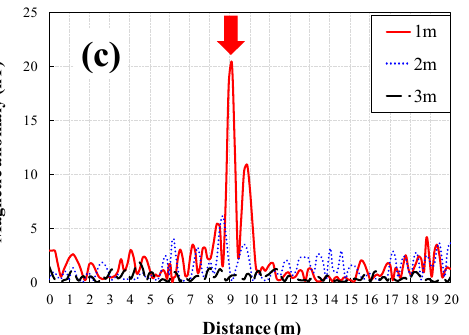
Figure 6. Profile of the proposed data-processing method: ( a ) raw magnetic field along the profile; ( b ) Gaussian-filtered magnetic field using a filter of fc = 10 Hz; ( c ) field detrended using the moving average method. Red Arrow indicate M16 landmine.